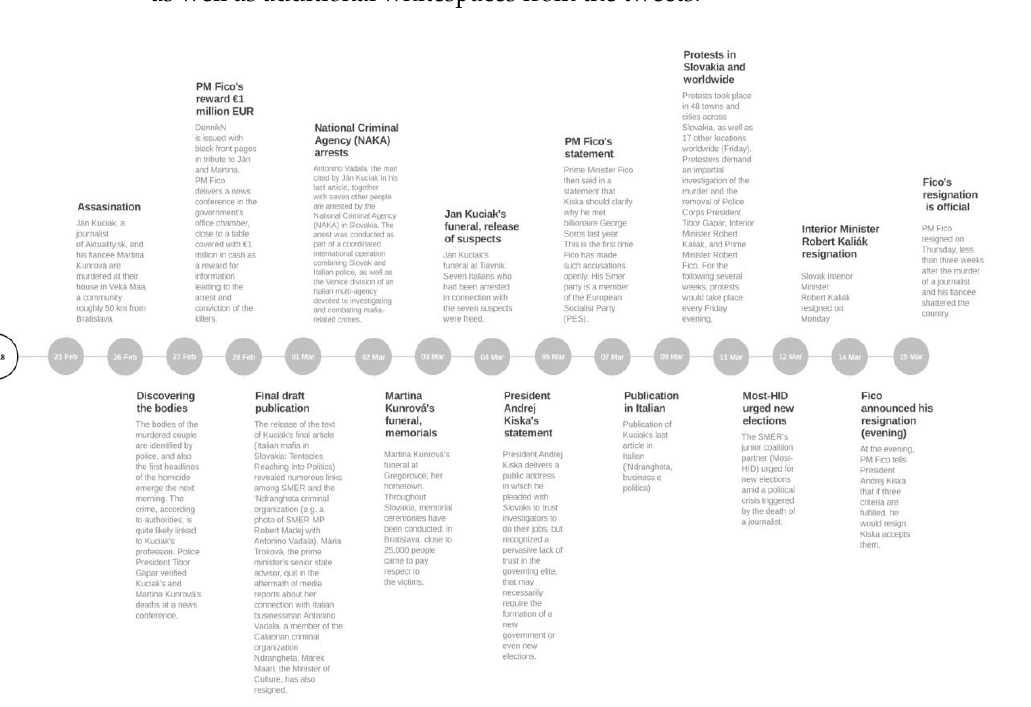
Figure 1. Overview of the timeline for the analysis period (26 February to 15 March 2018) representing the most important events and news (based on The Slovak Spectator [48]).